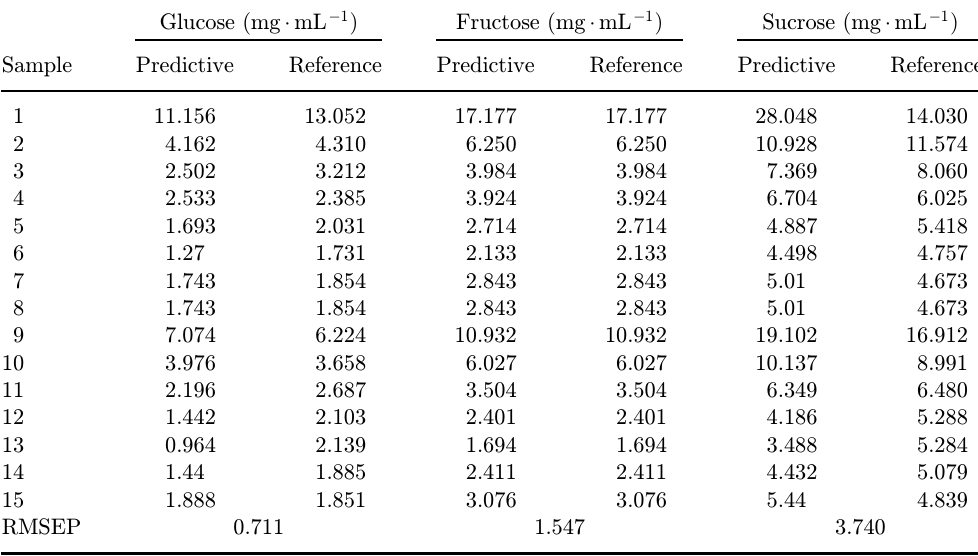
Table 4. Predictive/reference values of external validation for glucose, fructose, and sucrose models.